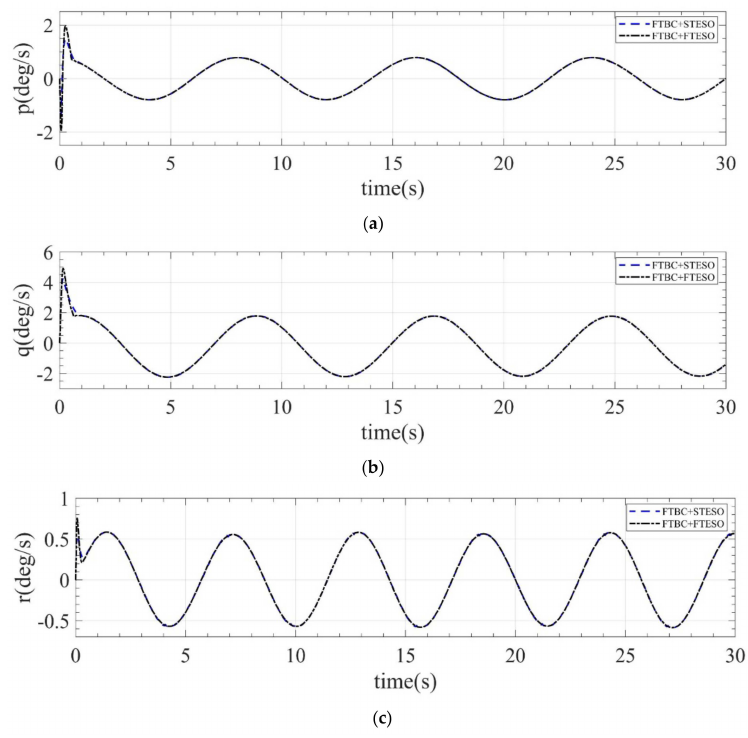
Figure 6. ( a ) Tracking curve of p, ( b ) tracking curve of q, and ( c ) tracking curve of r.